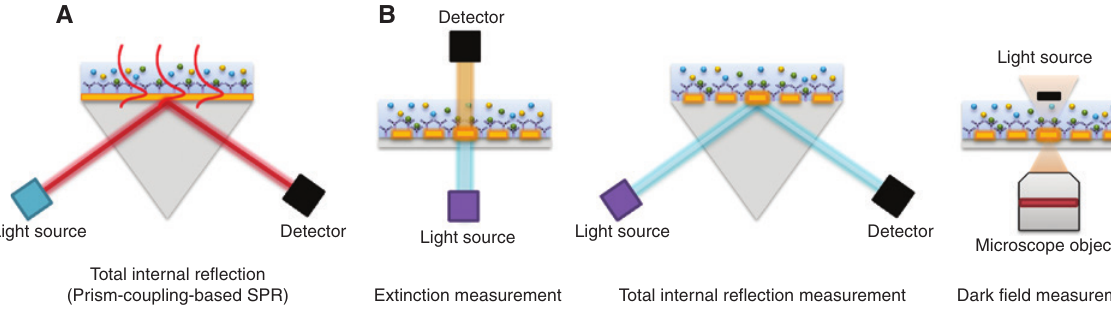
Figure 1: Schemes representing the most common configurations for (A) SPR and (B) LSPR